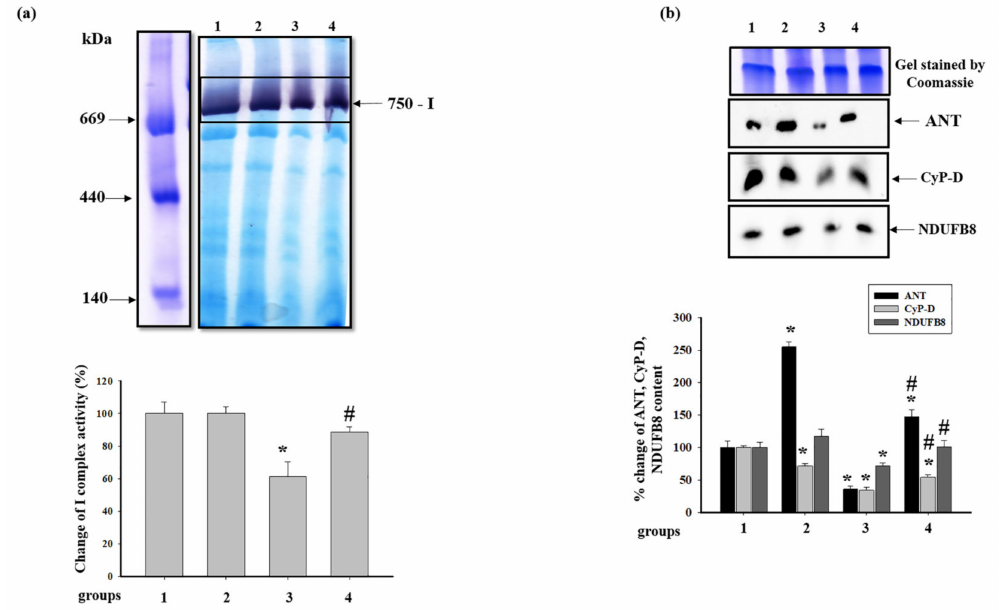
Figure 5. E ff ect of AST and ISO on the activity of complex I (CI) in rat heart mitochondria. ( a ) The upper part: freshly prepared rat mitochondria isolated from each group were solubilized in a bu ff er for blue native electrophoresis (BNE) samples (Materials and Methods section). Mitochondrial samples were separated by 1D BNE, and the gel was stained for the detection of the activity of CI by a bu ff er containing 100 mM Tris-HCl, pH 7.4, 0.14 mM NADH, 1 mg / mL NBT (nitro blue tetrazolium) for ~10–30 min; the lower part, a diagram quantitatively reflecting changes in the activity of CI; ( b ) the upper part: excised bands with enzymatic activity were subjected to 2D SDS-PAGE and blotted on nitrocellulose for immunodetection using the polyclonal antibody against ANT1 and monoclonal antibodies against CyP-D and NDUFB8 (NADH dehydrogenase [ubiquinone] 1 beta subcomplex subunit 8 of CI); the lower part: a diagram quantitatively reflecting changes in protein levels. The data are presented as the means ± SDs of four independent experiments. * p < 0.05—significant di ff erence in the protein level compared with the control (group 1), # p < 0.05 compared to RHM from ISO-injected rats (group 3). The statistical significance of the di ff erences between the pairs of mean values was evaluated using the Student-Newman-Keul test (Supplementary Materials, p.